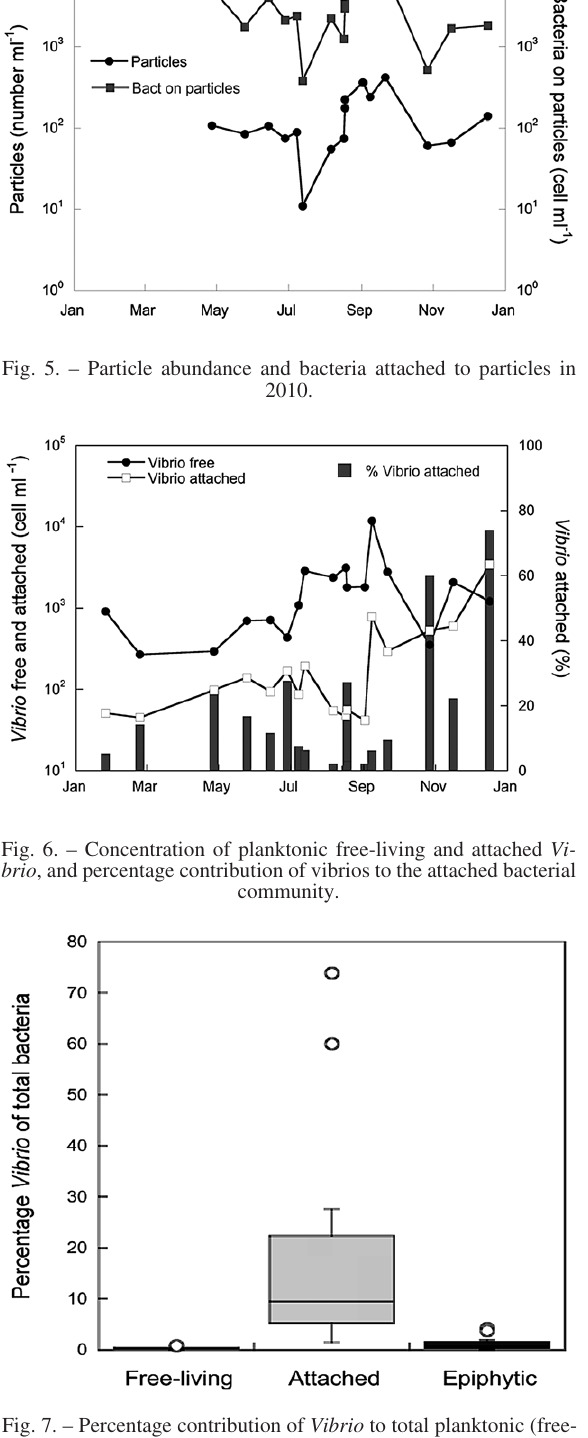
Fig. 7. – Percentage contribution of Vibrio to total planktonic (free- living or attached to particles) and epiphytic bacterial